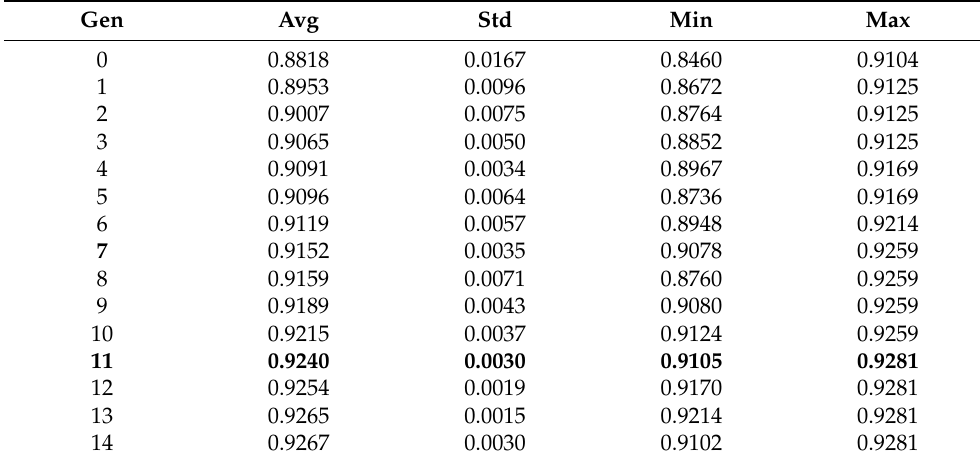
Table 3. Results after varying the number of generations (Gen).